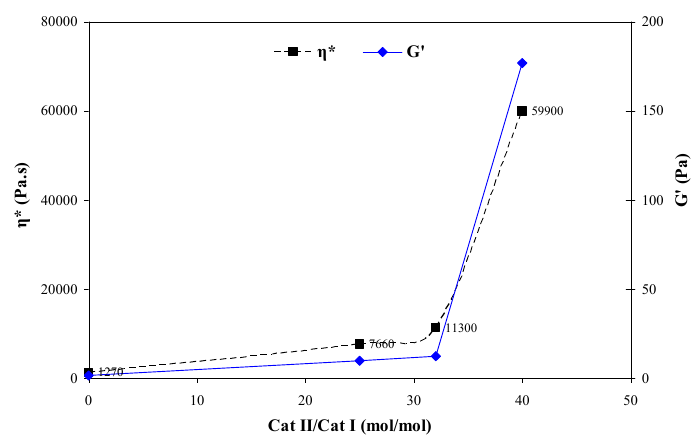
Figure 5. Complex viscosity versus frequency for the synthesized PP reactor blends.